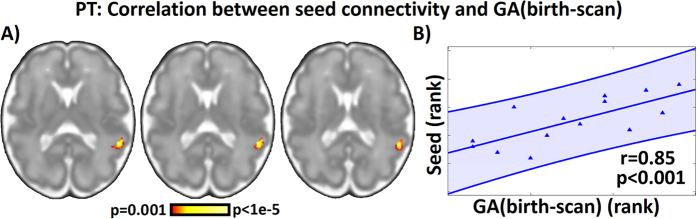
Whole brain regression of time between scan and birth for fetuses (n = 14) subsequently born preterm.Using the same seed connectivity as in Fig. 2, we investigated whether specific connections to the seed region were associated with increased time between fetal MRI and birth. (A) Connectivity between the left hemisphere proto-language seed and right hemisphere language homologues in the parietal lobes were significantly correlated (p < 0.05, corrected) with increased time between fetal MRI and birth. No regions exhibited a significant negative correlation. This association suggests that cross-hemisphere connectivity between language regions may be predictive of longer in utero development for those at risk of preterm birth. Connectivity values averaged from a seed centered on the peak difference and linear fit from spearman rank correlation are extracted for each subject and used to visualize the observed effect in (B). Using partial spearman correlation, these correlations remained significant after controlling for gestational age (GA) at scan (r = 0.78, 0 = 0.002, df = 11) and GA at birth (r = 0.83, p = 0.001, df = 11), suggesting a unique effect of time between fetal MRI and birth.